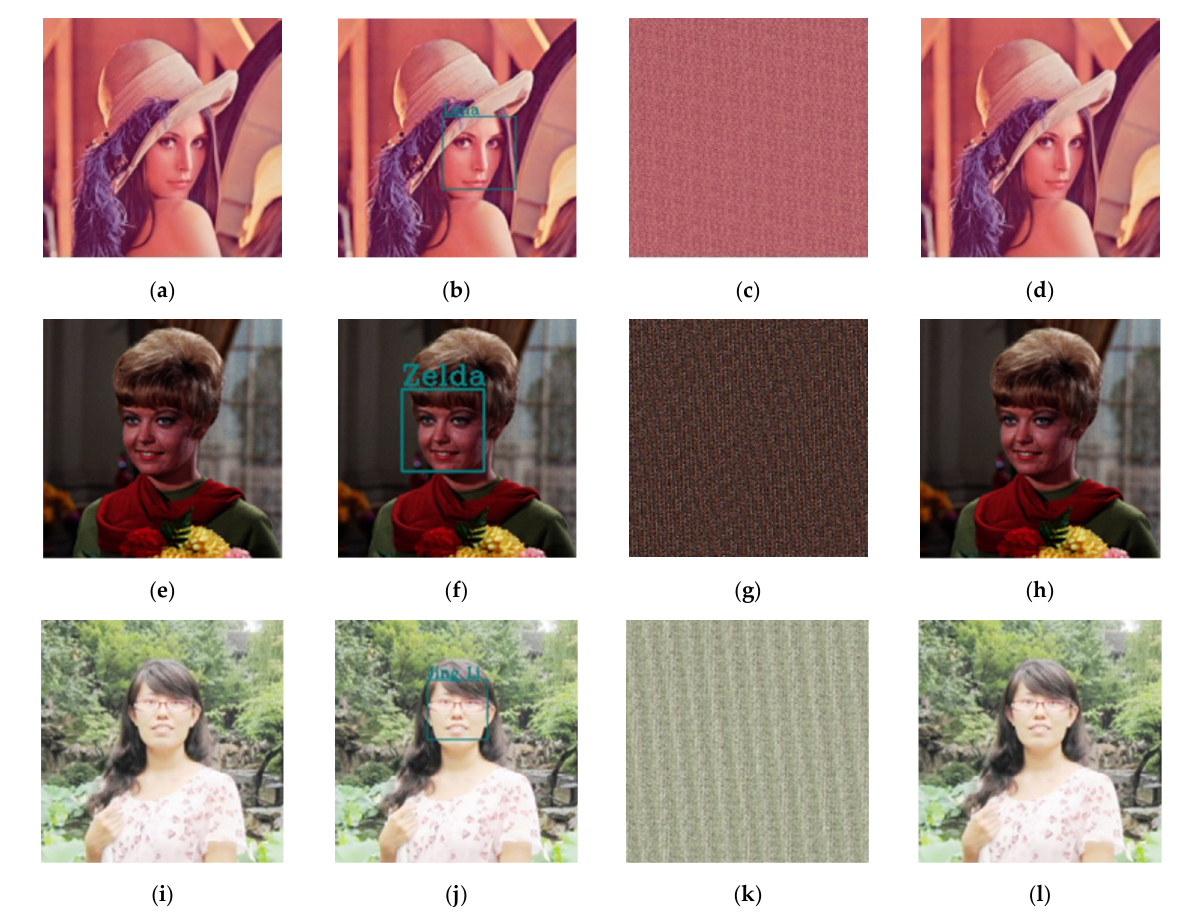
Figure 6. Image recognition, encryption and decryption. ( a , e , i ) Target image; ( b , f , j ) Face recognition image; ( c , g , k ) Logistic chaotic encryption; ( d , h , l ) Decrypted image.